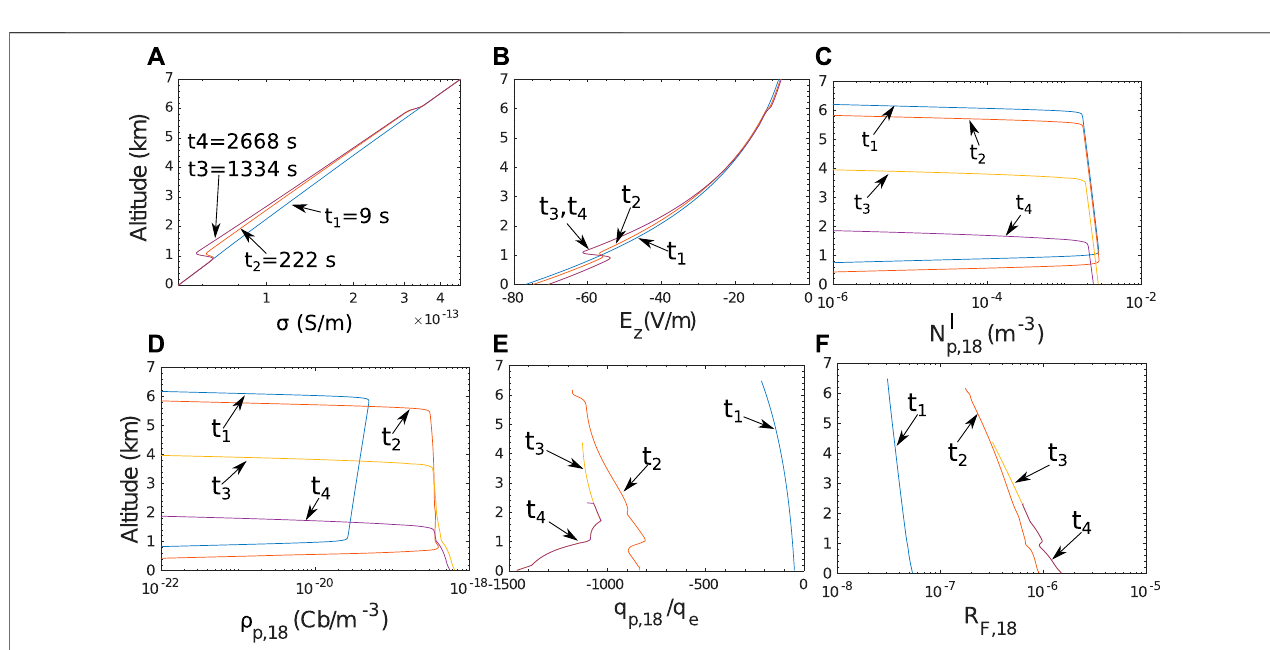
FIGURE7| Time dynamicsofelectrical propertiesofBin18 ( r (cid:1) 100 μ m): (A) Atmospheric conductivity, (B) largescale electric fi eld magnitude, (C) particlenumber density, (D) particle charge density, (E) number of elementary charges per particle, (F) ratio between the electrical force and the gravity.